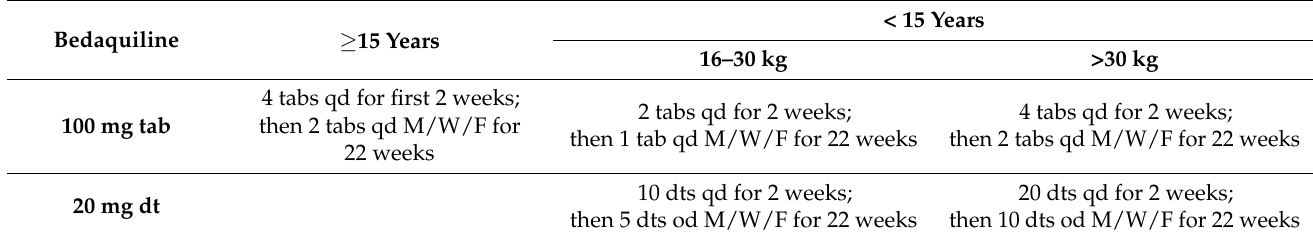
Table 5. Bedaquiline recommended dosing.